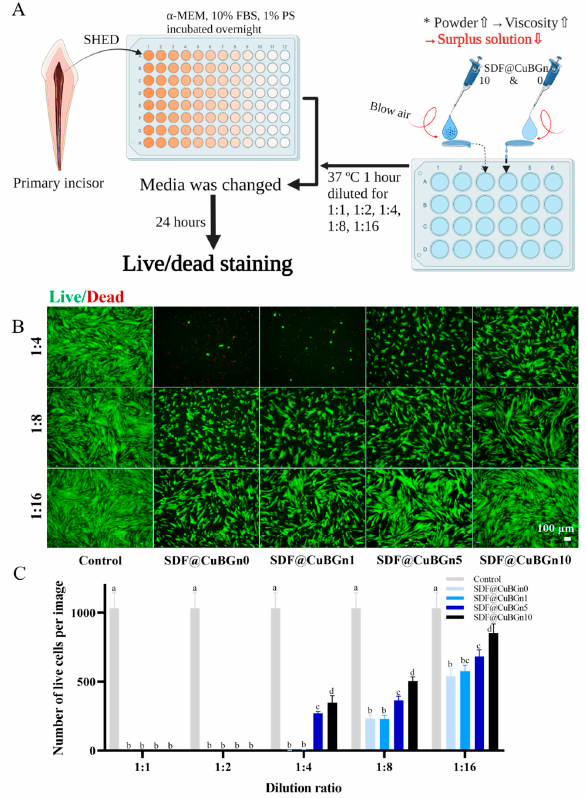
Figure 5. In vitro study of cytotoxicity on stem cells from human exfoliated deciduous teeth (SHED). ( A ) Schematic illustration of the cytotoxicity test of SDF@CuBGn on SHED. The higher the viscosity,